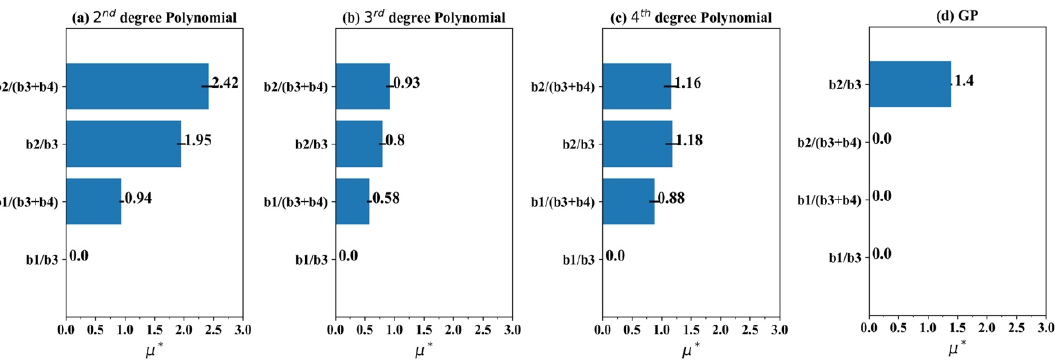
Figure 11. Sensitivity measure index ( µ ∗ ) for the summer day (2016.8.4); ( a ) 2 nd -degree MPR, ( b ) 3 rd -degree MPR, ( c ) 4 th -degree MPR, and ( d ) GP. Note that the higher values of µ ∗ for a given parameter indicate higher sensitivity of the model to the changes of the parameter.